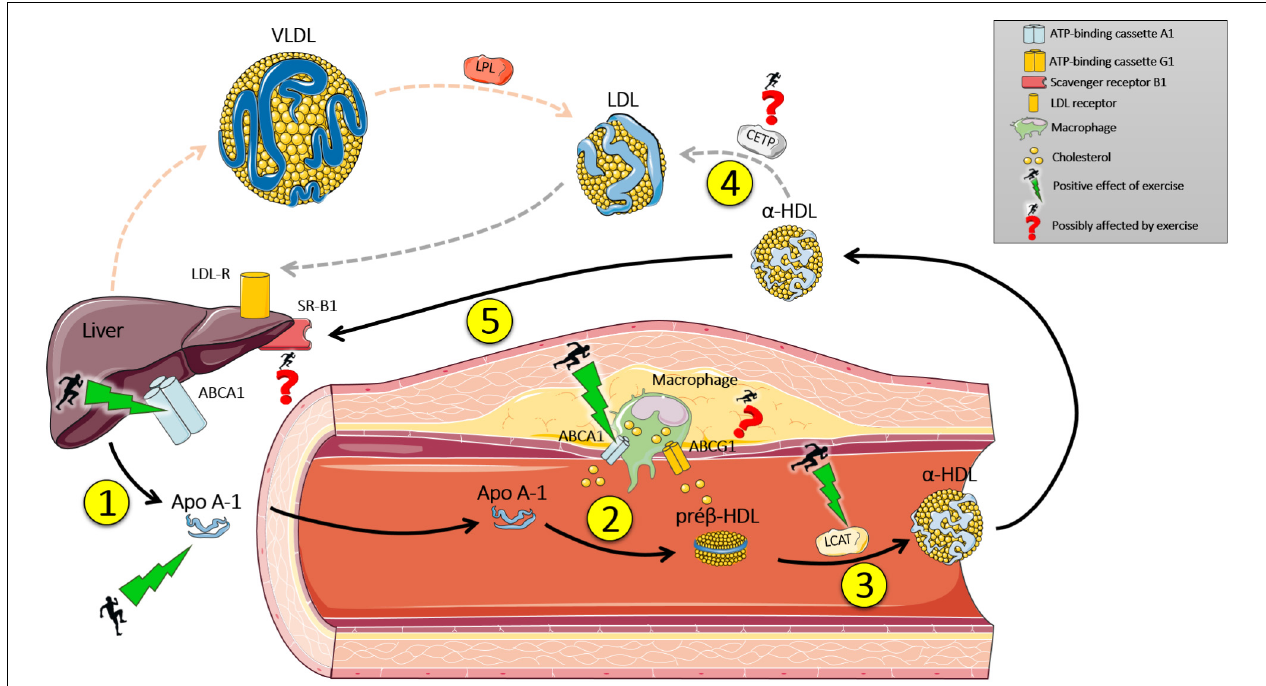
FIGURE 1 | Effect of exercise on reverse cholesterol transport (RCT). (1) The liver synthesizes Apo A-1 that enters the bloodstream. (2) Apo A-1 has an affinity to ABCA1, present in mononuclear cells of the immune system (macrophages), which transport cholesterol from the peripheral tissues to Apo A-1, which becomes a pre β -HDL (discoidal). (3) Pre β – HDL binds to ABCG1 which transports cholesterol from the peripheral tissues to the molecule, which is modified by LCAT enzyme (transporting cholesterol from the surface of the pre β – HDL surface to the central part) becoming α -HDL (mature HDL-c). (4) α -HDL is modified by the enzyme CETP, which replaces the lipid content of LDL-c (triacylglycerols) by cholesterol from α -HDL, and then binds to its receptor in the liver (LDL-R) and deposits its cholesterol contents. (5) Or, α -HDL can return to the liver and transfer its cholesterol content to the liver through SR-B1. Next, cholesterol can be reused or expelled by the gallbladder. Exercise can modulate genetic and protein expression of Apo A-1, ABCA1 hepatic and immune system cells, and increase the activity of Lecithin-cholesterol acyltransferase (LCAT). Studies about the effect of exercise on cholesteryl ester transfer protein (CETP) activity, SR-B1, and ABCG1 expression are inconclusive. Black arrows indicate direct RCT. Dotted gray arrows indicate indirect RCT. Dotted red arrows indicate the hepatic secretion of VLDL, which is modified by lipoprotein lipase (LPL) in the bloodstream and hydrolyzes its lipid content to peripheral tissue and subsequently becomes LDL-c. Apo A-1, Apolipoprotein